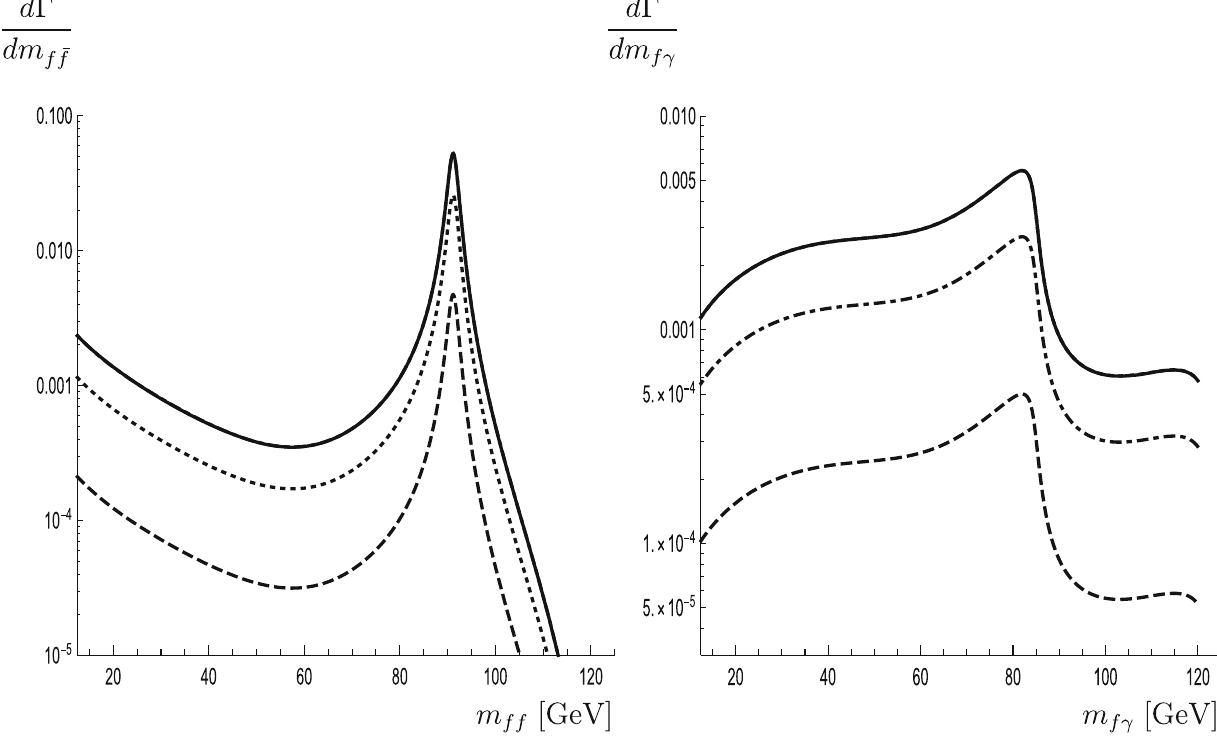
Fig. 13 Differential of the decay width as functions of m f f and m f